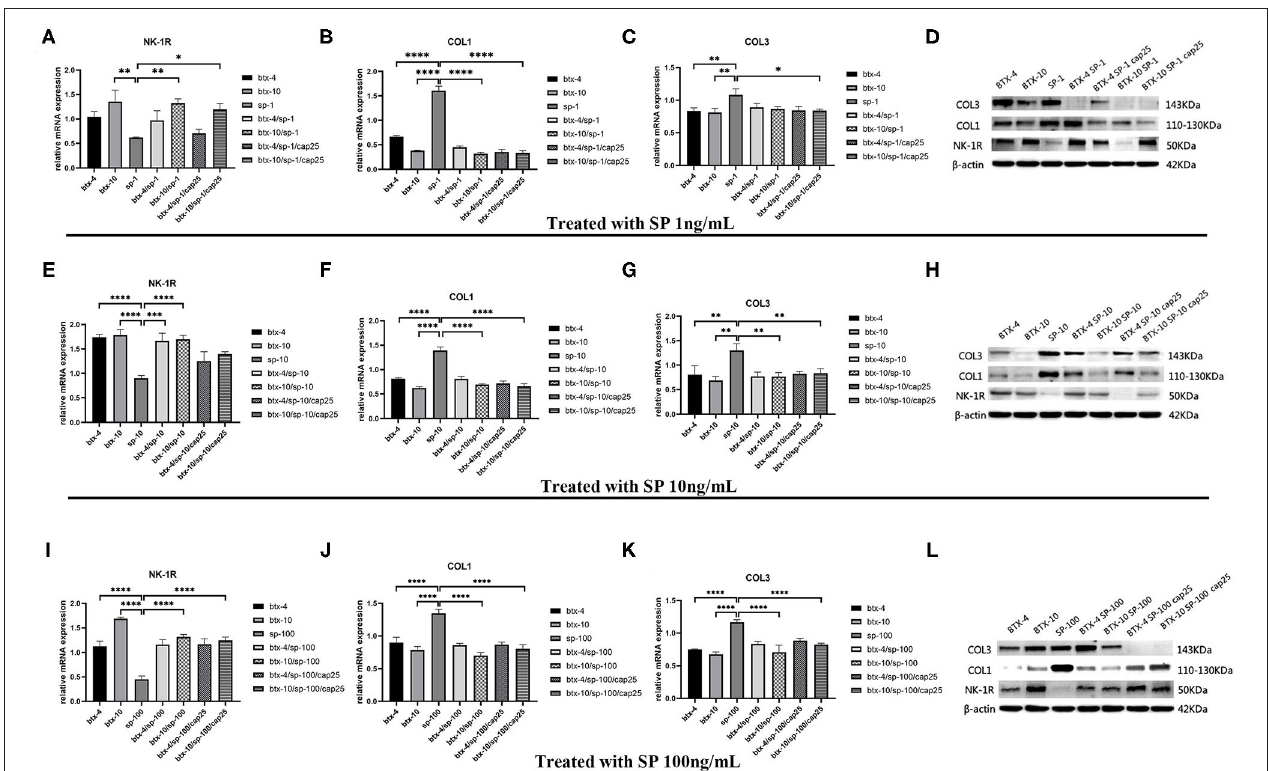
FIGURE 5 | The mRNA and protein expressions were from hypertrophic scar-derived fibroblasts treated with increasing concentrations of SP. (A–C) Relative mRNA expression of NK-1R , type 1 and 3 collagen after treatment with 1ng/ml SP alone, 4 or 10 U/mL BTX-A with or without 1ng/mL SP and 25 µ M/L capsaicin; (D) Expression of NK-1R, type 1 and 3 collagen 2h after treatment with 1ng/ml SP alone, 4 or 10 U/mL BTX-A with or without 1ng/mL SP and 25 µ M/L capsaicin detected by western blot analysis; (E–G) Relative mRNA expression of NK-1R , type 1 and 3 collagen after treatment with 10ng/ml SP alone, 4 or 10 U/mL BTX-A with or without 10ng/mL SP and 25 µ M/L capsaicin; (H) Expression of NK-1R, type 1 and 3 collagen 2h after treatment with 10ng/ml SP alone, 4 U/mL or 10 U/mL BTX-A with or without 10ng/mL SP and 25 µ M/L capsaicin detected by Western blot analysis; (I–K) Relative mRNA expression of NK-1R , type 1 and 3 collagen after treatment with 100ng/ml SP alone, 4 or 10 U/mL BTX-A with or without 100ng/mL SP and 25 µ M/L capsaicin; (L) Expression of NK-1R, type 1 and 3 collagen 2h after treatment with 100ng/mL SP alone, 4 or 10 U/mL BTX-A with or without 100ng/mL SP and 25 µ M/L capsaicin detected by western blot analysis. The results are represented as the mean of 3 experiments ± SD, which were performed in duplicate for each experimental condition (* P < 0.05; ** P < 0.01; *** P < 0.001; **** P <